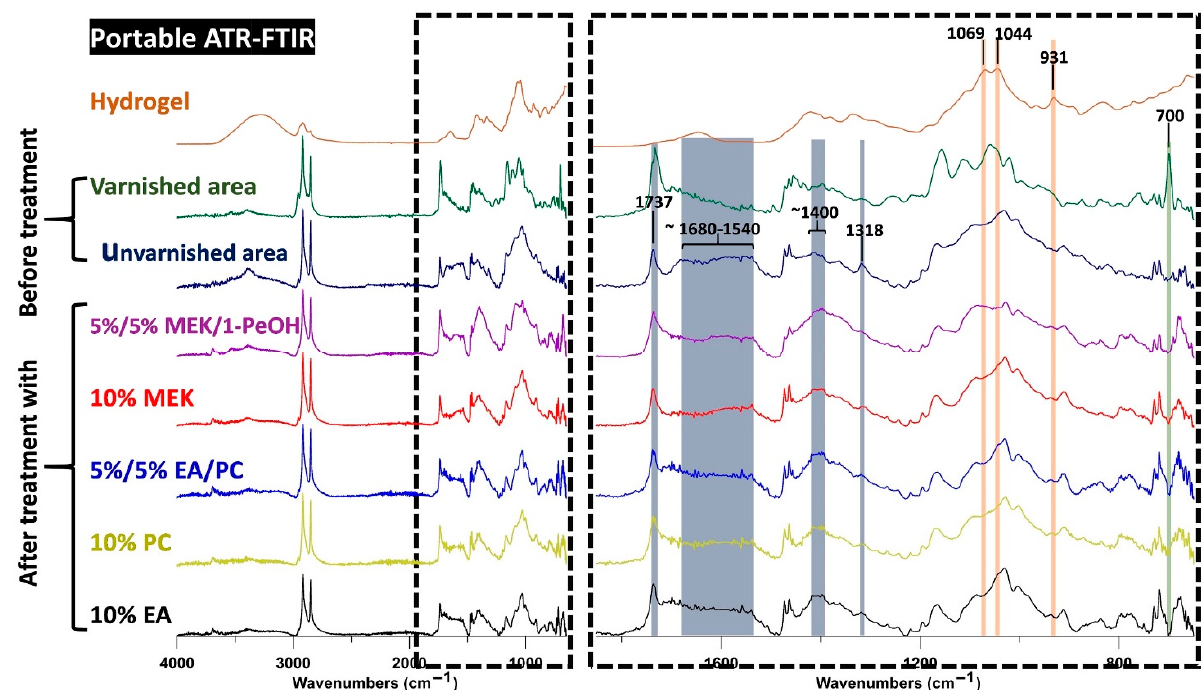
Figure 6. ATR–FTIR spectra of hydrogel, unvarnished and varnished paint layers, and spots treated with the five tested hydrogels in the first-stage tests.